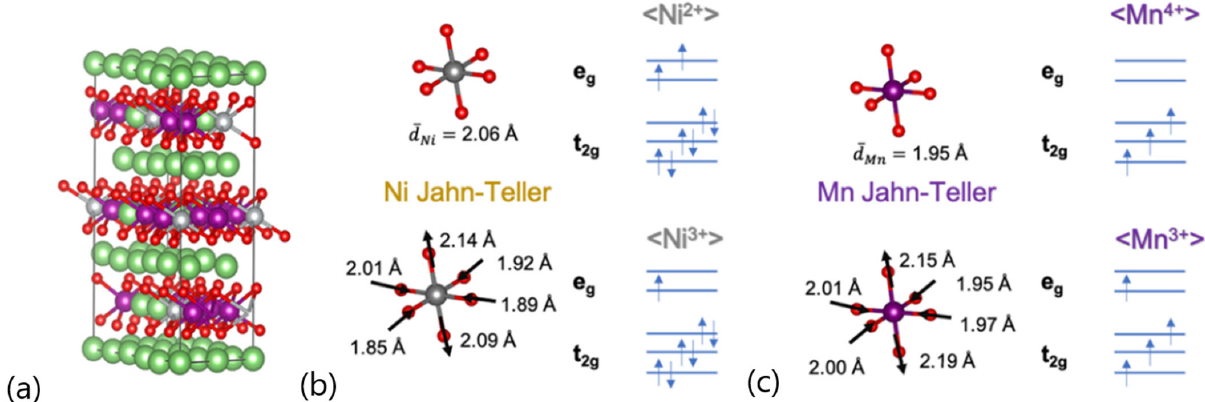
Figure 1. ( a ) Optimized geometry and volume structures supercell 5 × 2 × 1 containing 120 atoms of Li 1.2 Ni 0.2 Mn 0.6 O 2 (LNM) phase; ( b ) Ni-O and ( c ) Mn-O bond distances also considering Jahn–Teller centers. Color code: Li—green, Ni—gray, Mn—violet, O—red.